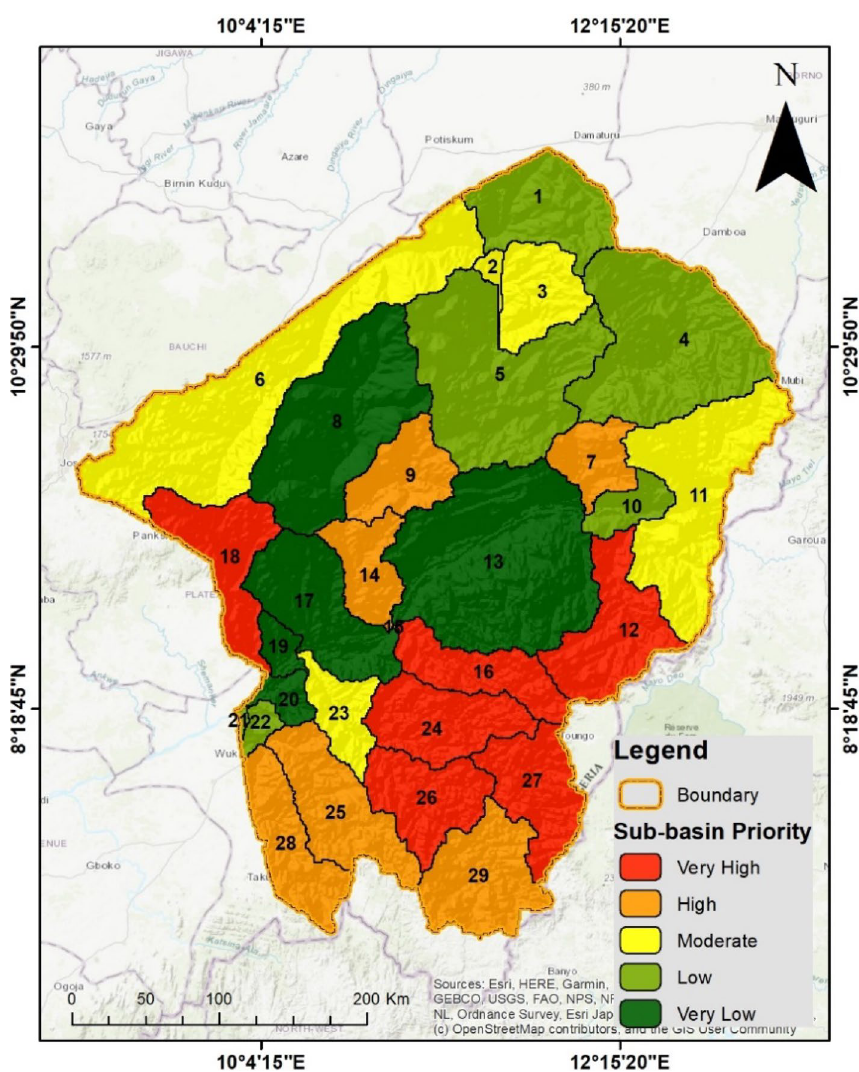
Fig. 10 Prioritized upper Benue River